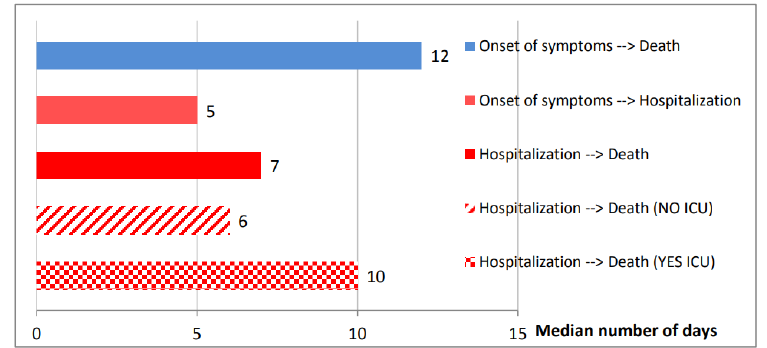
Figure 7. Median times, in days, from the onset of symptoms to death, to hospitalization, from hospitalization to death with and without intensive care unit (ICU)-admittance (Report based